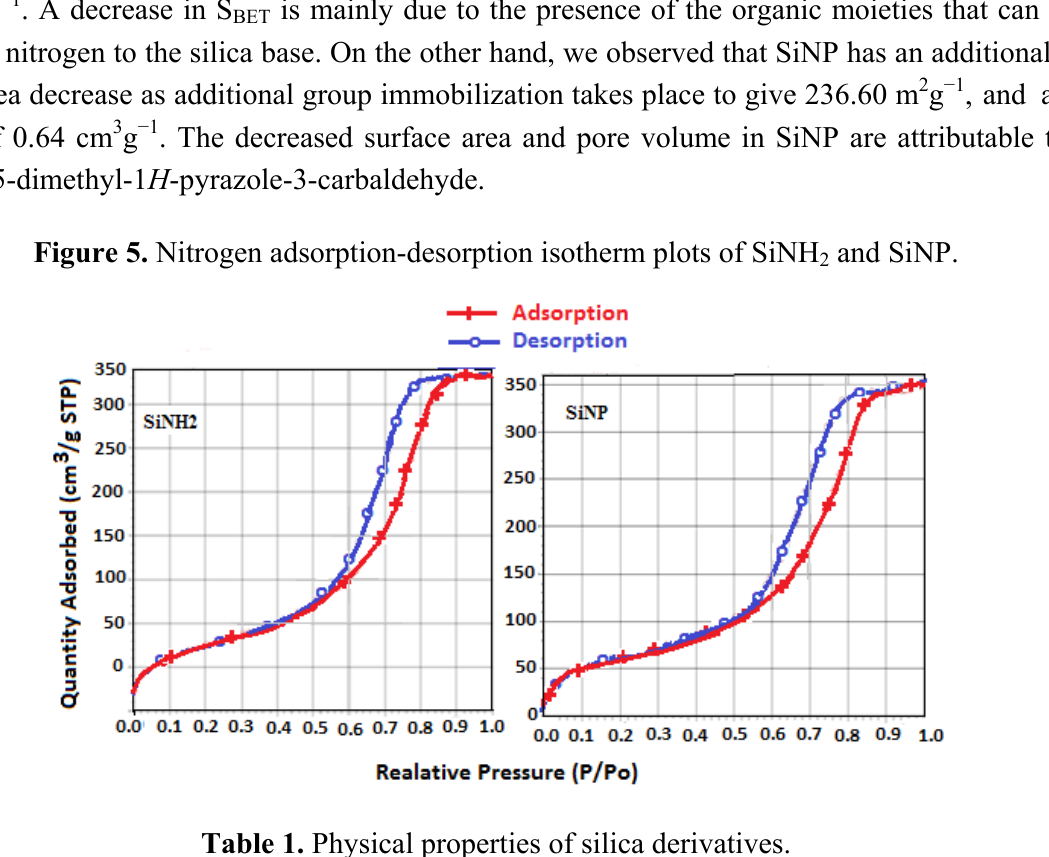
Figure 5. Nitrogen adsorption-desorption isotherm plots of SiNH